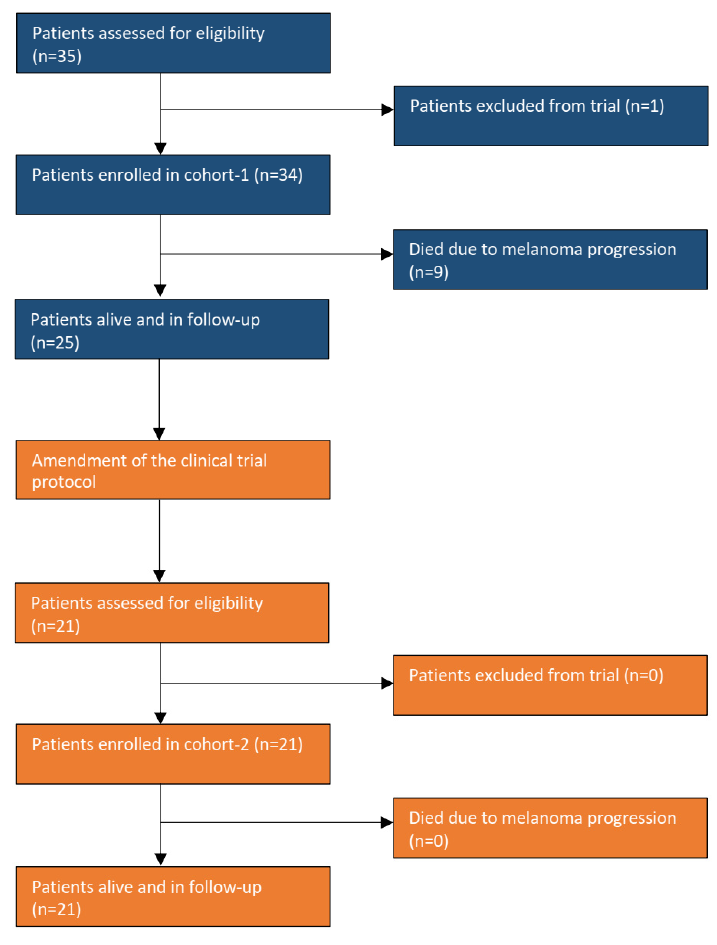
Figure A1. CONSORT-diagram. Patients enrolled to cohort-1 (prior to the trial amendment) are depicted in blue, patients enrolled in cohort-2 (after the trial amendment) are depicted in orange. Table A1. Immune characteristics of melanoma metastases.